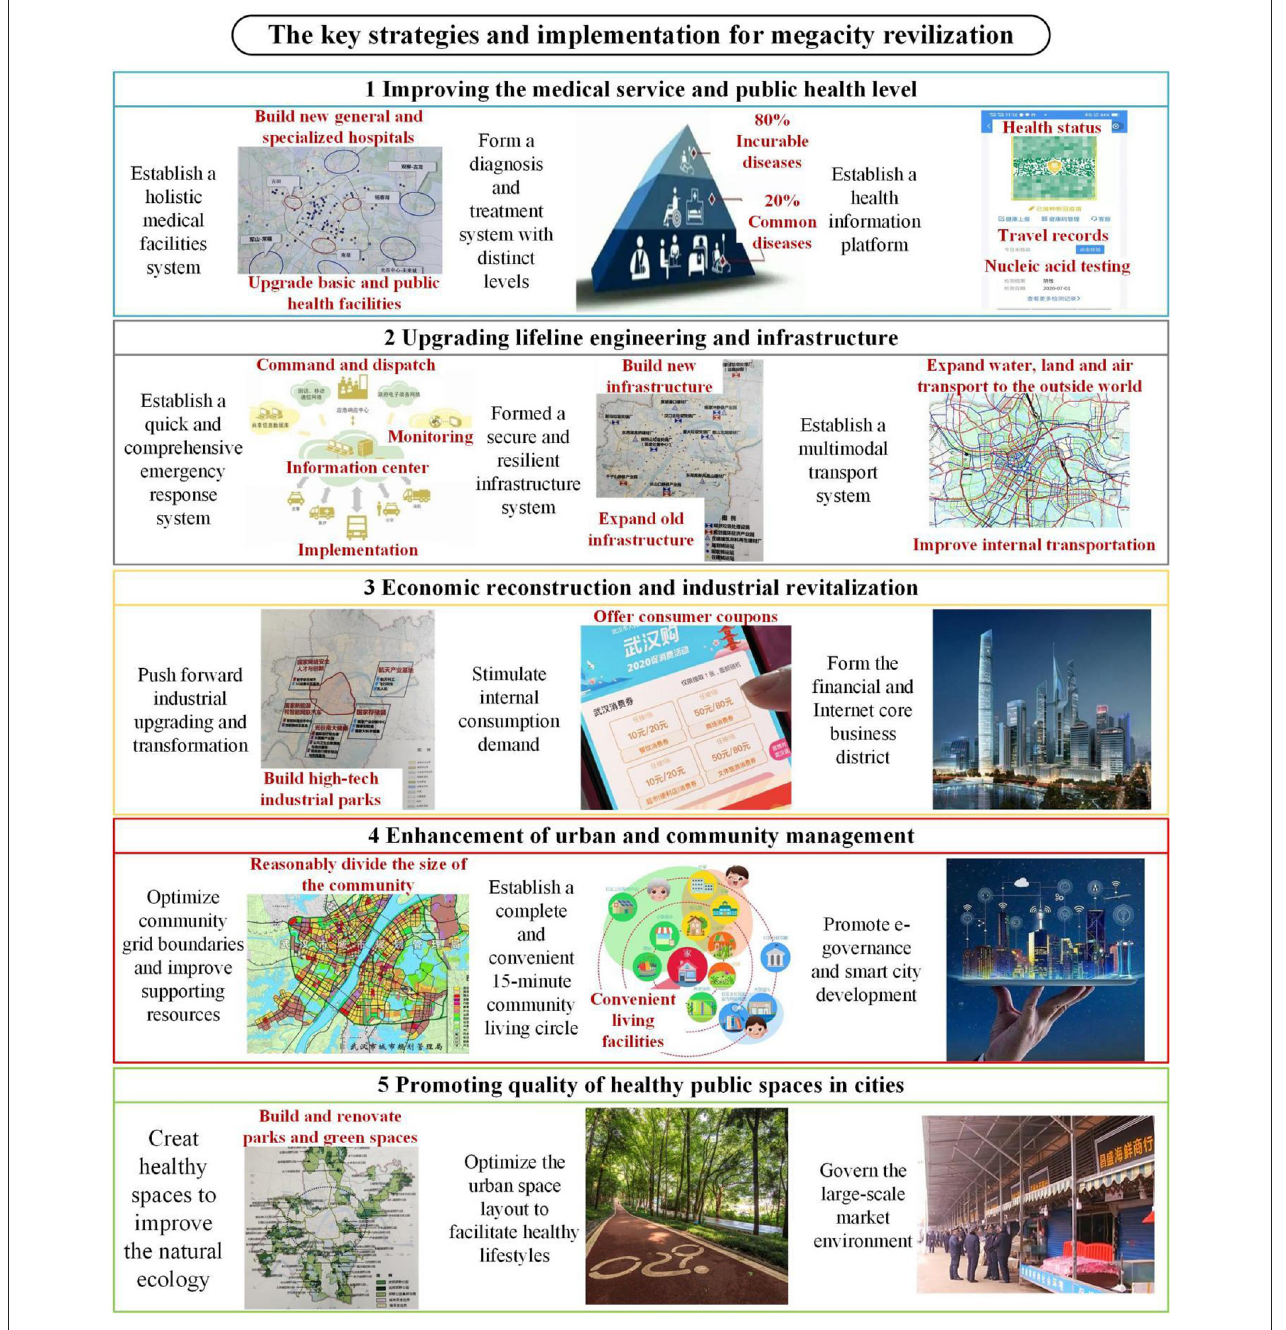
FIGURE 1 | Goals of and specific measures for a megacity plan for postpandemic